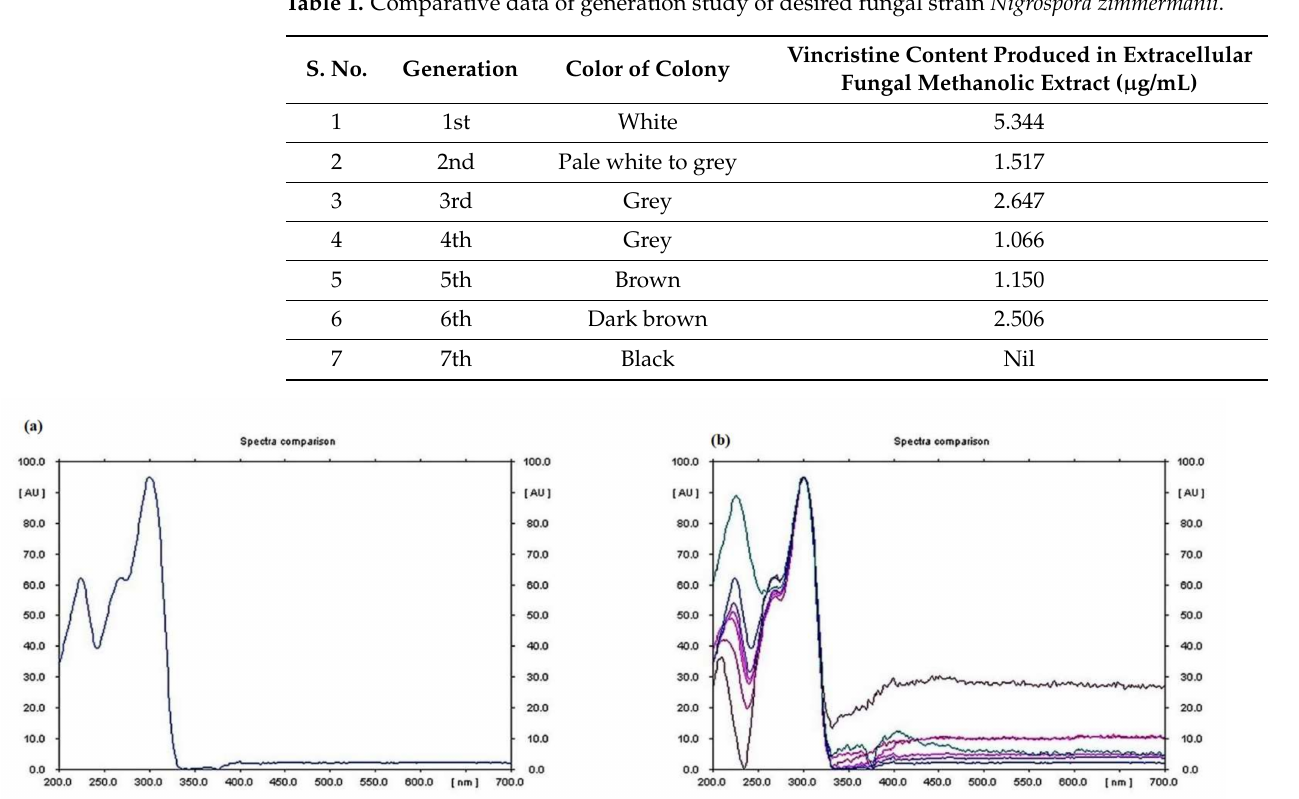
Figure 7. Spectral data for vincristine, showing ( a ) λ max at 300 nm in standard; ( b ) λ max at 300 nm in